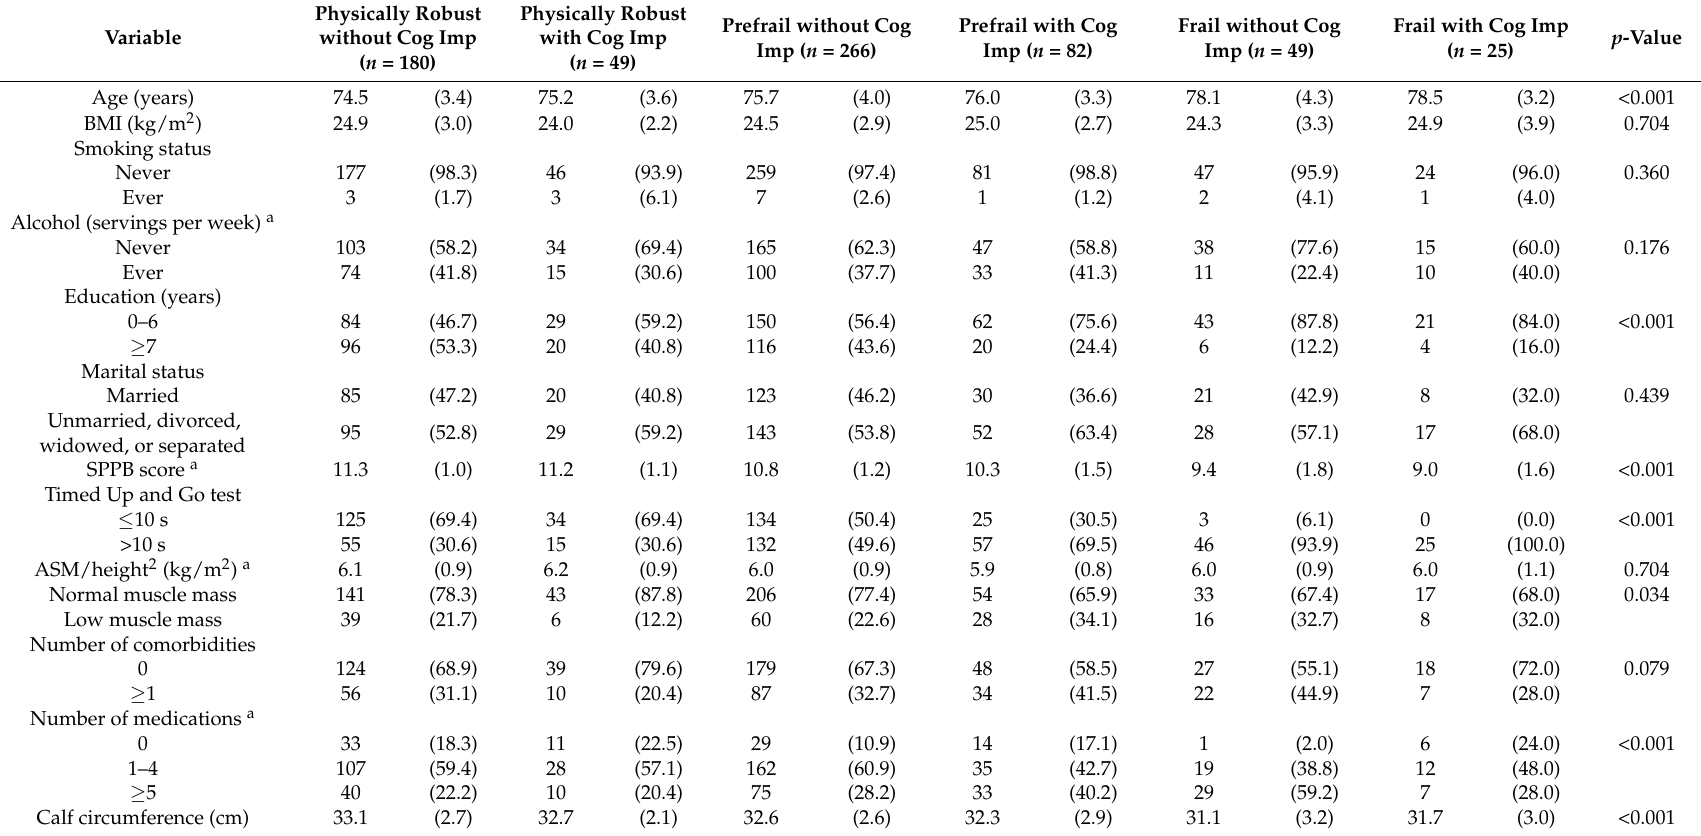
Table 2. Characteristics of the female participants ( n = 651) according to physical frailty and cognitive impairment